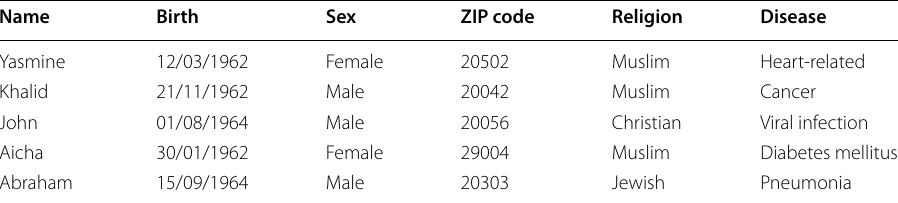
Table 3 A non-anonymized database comprising of the patient records Name